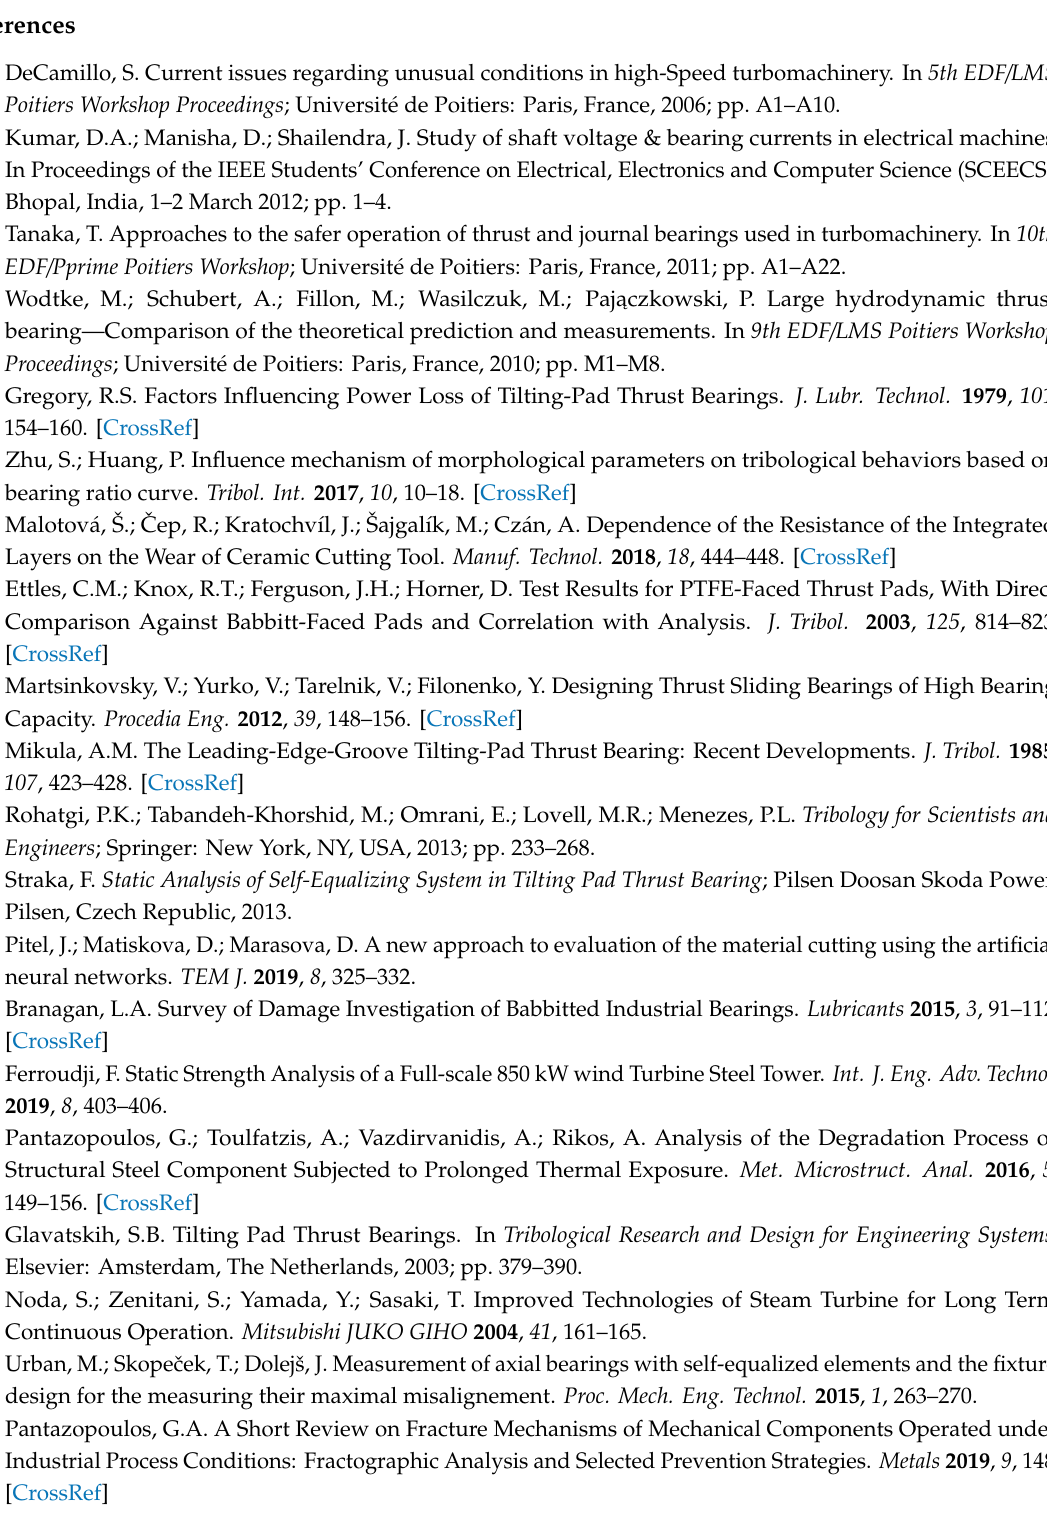
material portion 2: Level in (%), determined for the intersection line which separates the deep Mr2 valleys from the roughness core profile. A1 Peak area Valley